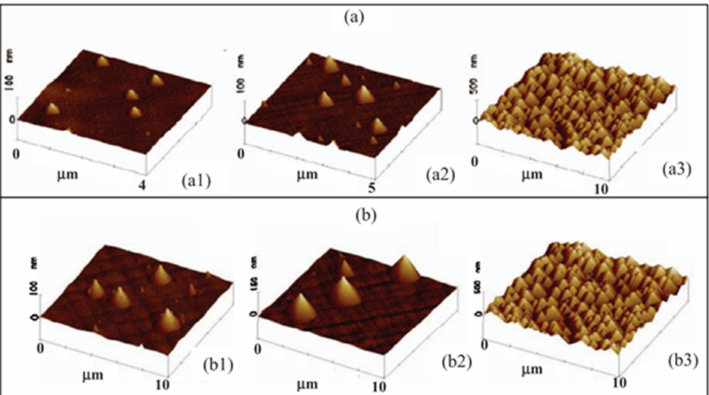
Figure 13. AFM images of ( a ) GeSn with an Sn content of 6.4%; the strain relaxations for ( a1 ), ( a2 ), and ( a3 ) are 8%, 33%, and 75%, respectively. ( b ) GeSn with a strain relaxation of 75%; the Sn contents of ( b1 ), ( b2 ), and ( b3 ) are 12.6%, 8.1%, and 6.4%, respectively. Reproduced with permission from